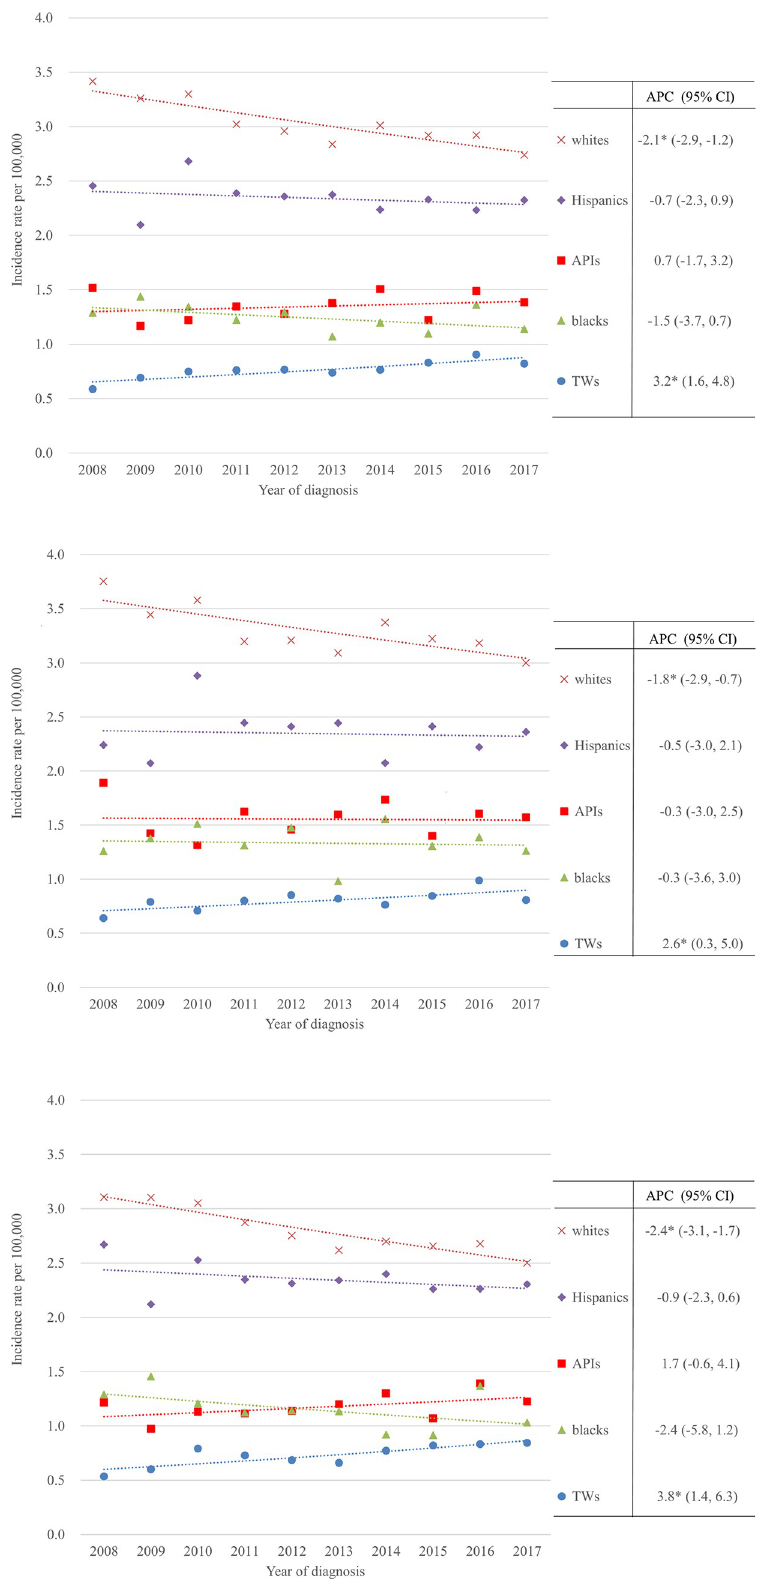
Fig 1. Trends in the world age-adjusted incidence rate according to racial group for the period 2008–2017. (A) Overall. (B) Males. (C) Females. � The APC is significantly different from 0 at the alpha level of 0.05. https://doi.org/10.1371/journal.pone.0265543.g001 PLOS ONE | https://doi.org/10.1371/journal.pone.0265543 March 17,